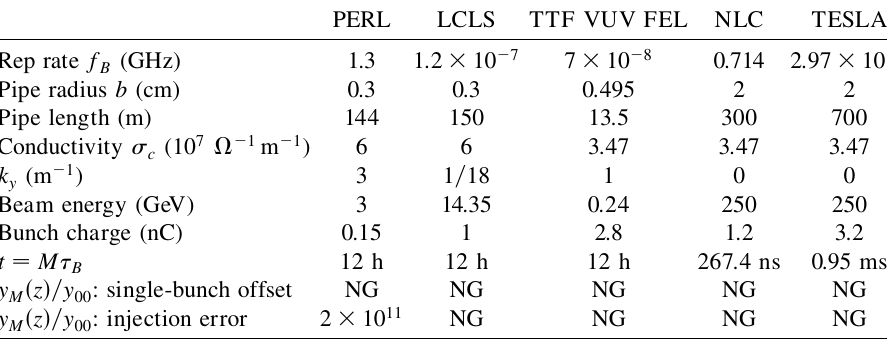
TABLE I. Summary of the parameters and results for the PERL project, the LCLS project, the existing TTF VUV FEL, the FFS of the NLC project and the FFS of the TESLA project. ‘‘NG’’ in the table stands for negligible